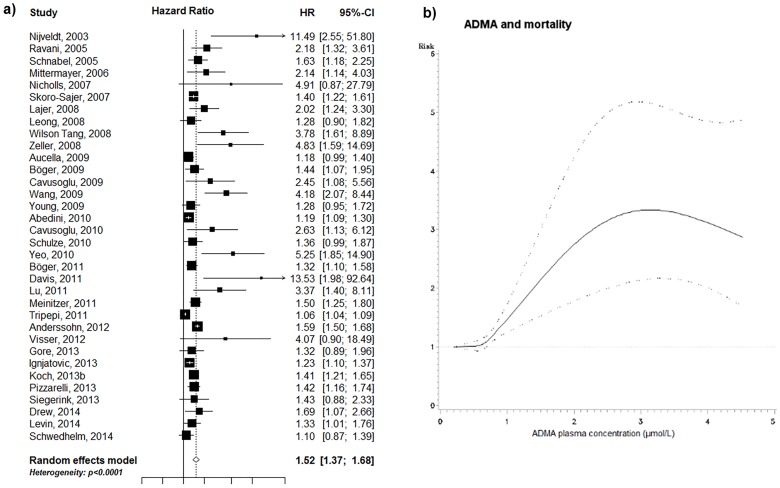
ADMA and all-cause mortality: a) high versus low analysis, and b) non-linear dose-response analysis (based on 7 studies, p for non-linearity = 0.035).Black square: point estimate for individual study; horizontal line: 95% CI for observed effect in each study; diamond: pooled estimate and 95% CI for meta-analysis. Random-effects estimate (DerSimonian and Laird method).